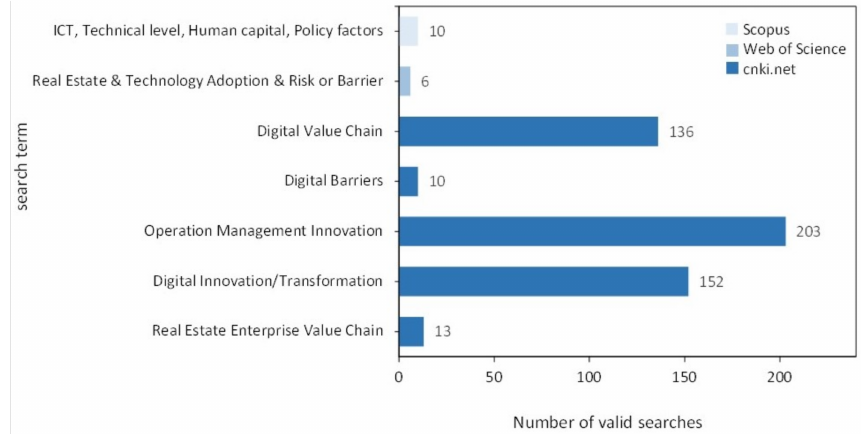
Figure 1. Search